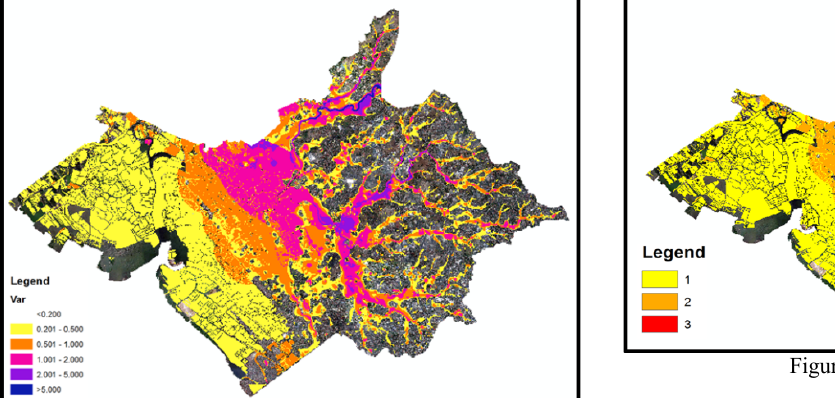
Figure 5. 2000 Flow Depth Map